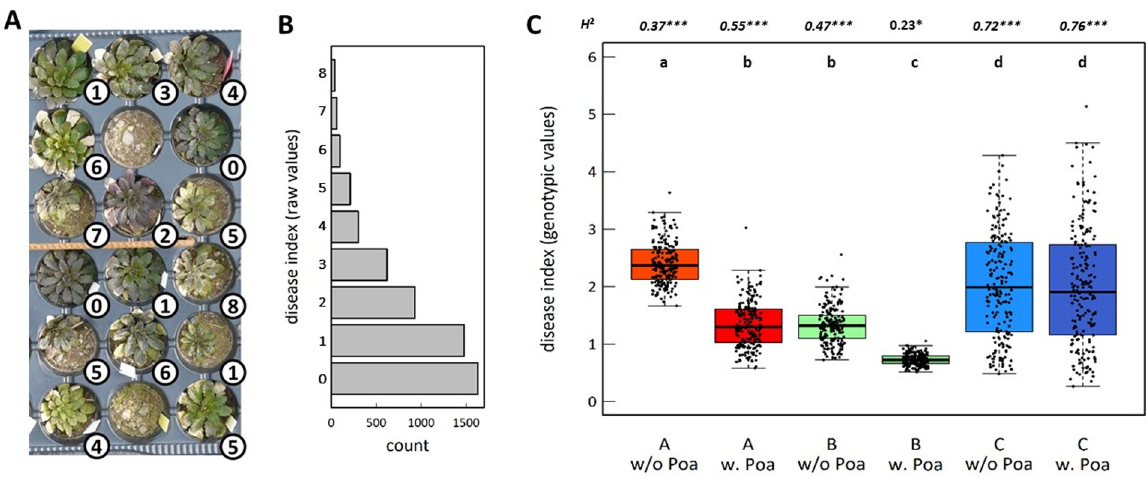
Fig 1. Genetic variation among the 195 TOU-A accessions for disease index across the six micro-habitats. (A) Photograph illustrating the observed variation in the level of disease index ranking from zero to eight. Each value on the bottom right of each plant indicates the level of disease index scored on March 3 rd , 2013. (B) Variation of disease index across the 5,367 plants scored in this study. (C) Genetic variation within each micro-habitat. Each dot corresponds to the genotypic values (Best Linear Unbiased Estimator) for disease index of one of the 195 accessions. ‘A w/o Poa’: soil A in absence of Poa annua , ‘A w. Poa’: soil A in presence Poa annua , ‘B w/o Poa’: soil B in absence of Poa annua , ‘B w. Poa’: soil B in presence Poa annua , ‘C w/o Poa’: soil C in absence of Poa annua , ‘C w. Poa’: soil C in presence Poa annua . Different upper letters indicate different groups according to the micro-habitat after a Tukey correction for multiple pairwise comparisons. H 2 : broad-sense heritability value for each microhabitat. Italic values indicate statistically significant results after a Bonferroni correction for multiple comparisons. ��� P < 0.001, � P < 0.05.